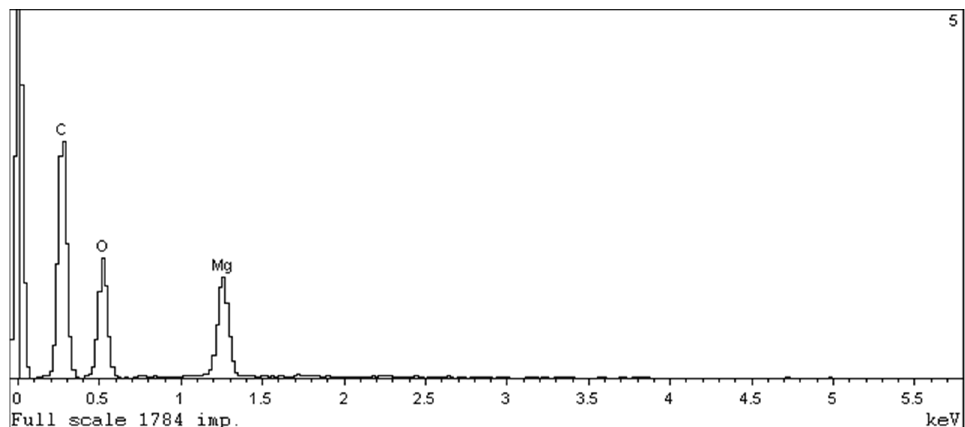
Figure 4. EDX spectrum of crystallized CPO-27-Mg.